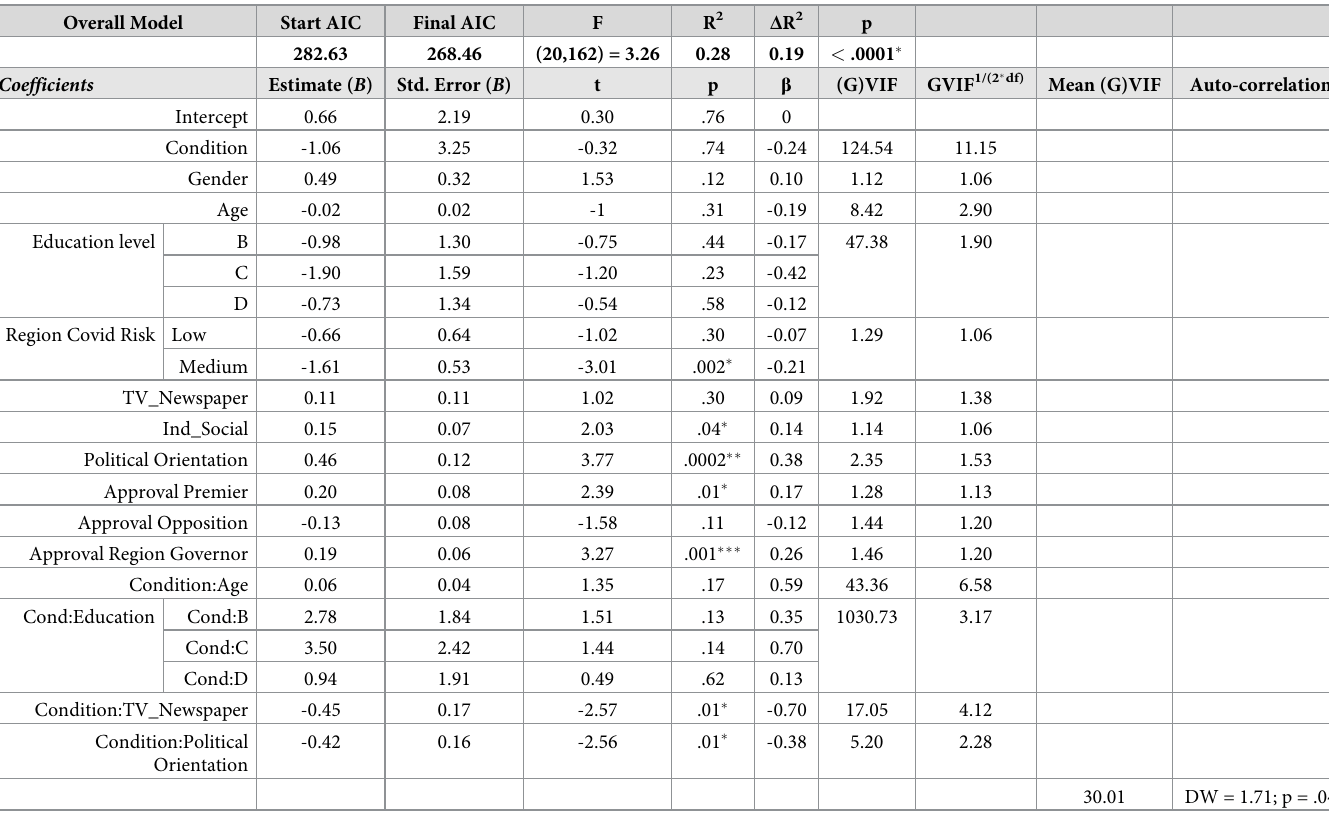
Table 2. Multiple regression statistics for the final overall model.